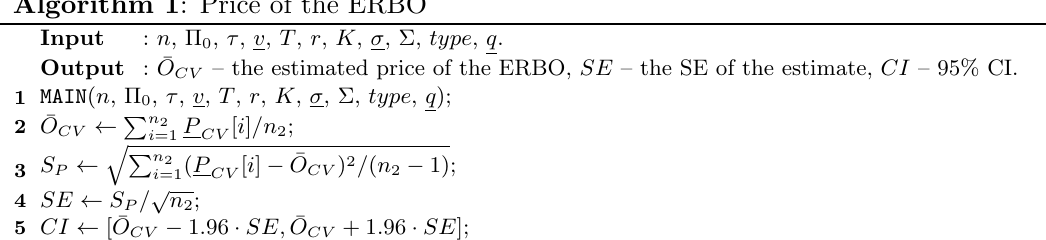
Algorithm 1 : Price of the